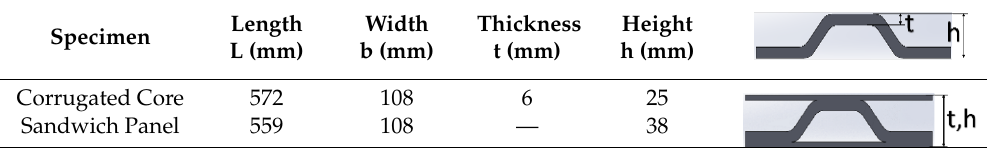
Figure 4. Finite element (FE) model of 3-D core and sandwich panel in the longitudinal direction. Table 1. Dimensions of flexural specimens used in the bending test.